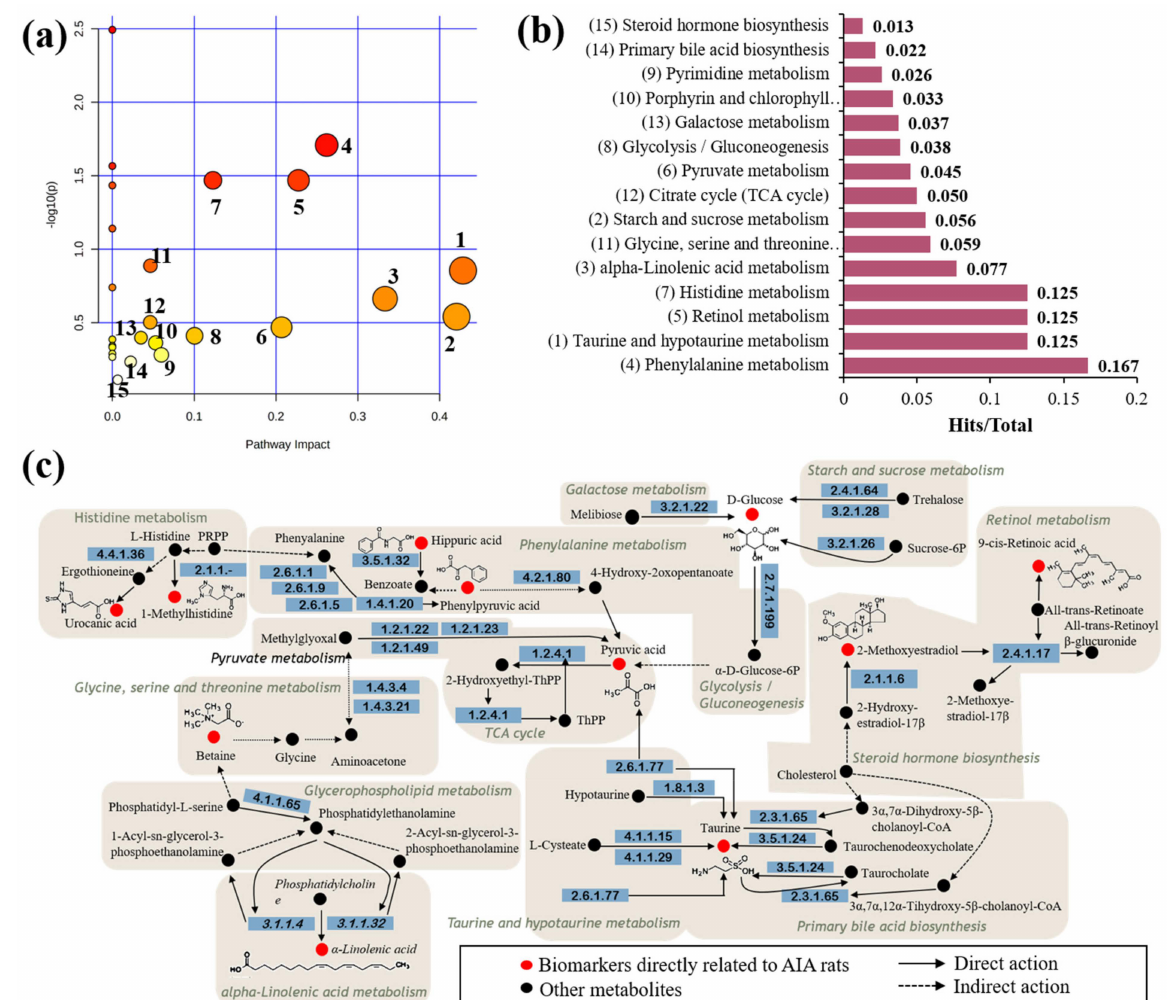
Figure 4. Enrichment analysis of MetPA metabolic pathway of biomarkers. ( a ) Pathway impact enrichment. (1) Taurine and hypotaurine metabolism. (2) Starch and sucrose metabolism. (3) Alpha- linolenic acid metabolism. (4) Phenylalanine metabolism. (5) Retinol metabolism. (6) Pyruvate metabolism. (7) Histidine metabolism. (8) Glycolysis or gluconeogenesis. (9) Pyrimidine metabolism. (10) Porphyrin and chlorophyll metabolism. (11) Glycine, serine, and threonine metabolism. (12)